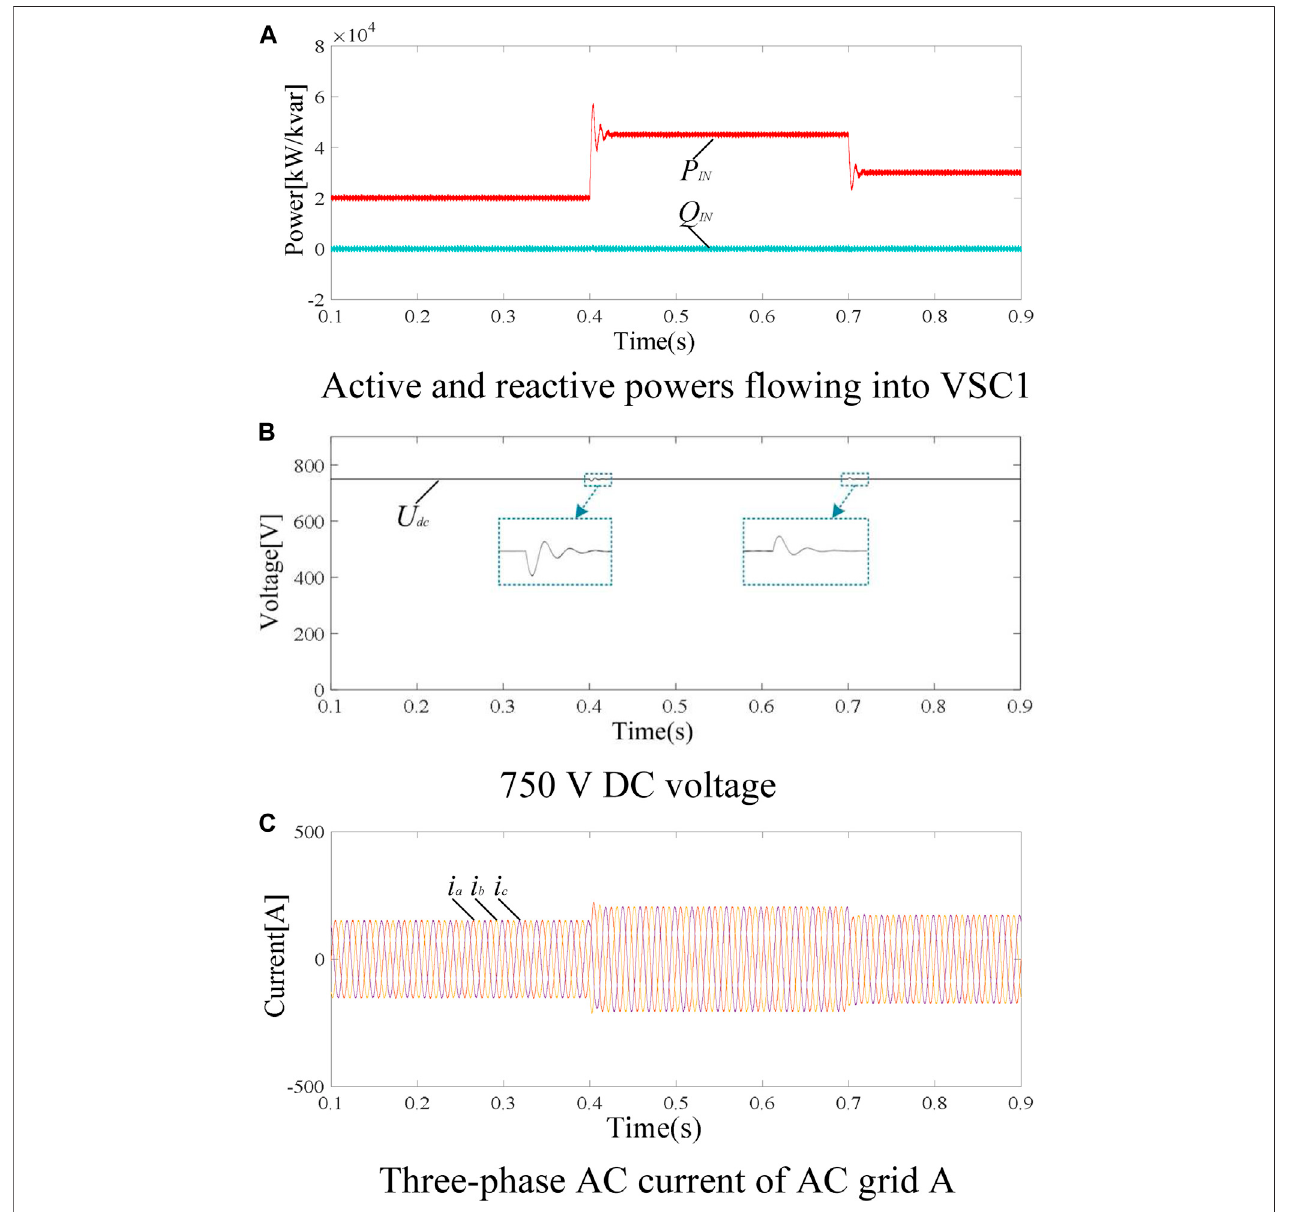
FIGURE5| DCload fl uctuationsimulationresults (A) Activeandreactivepowers fl owingintoVSC1 (B) 750 VDCvoltage (C) Three-phaseACcurrentofACgridA.